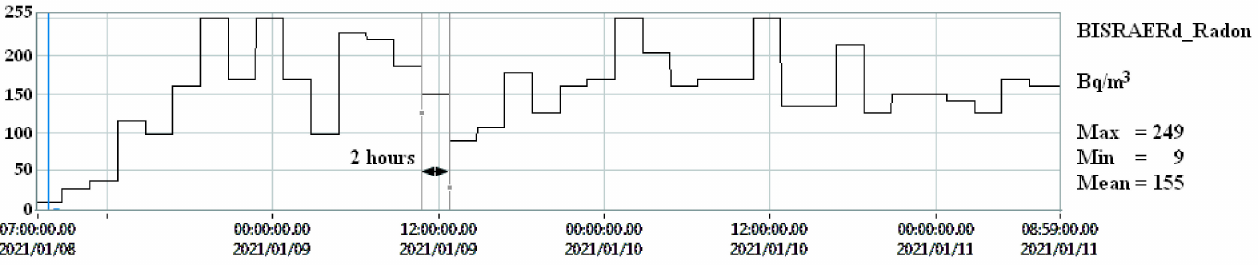
Figure 8. Radon data from AER +C with 2 h sample rate.